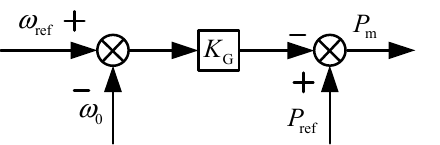
Figure 3. Control block diagram of synchronous generator governor. The active power–frequency control block diagram of the virtual synchronous gen- erator is in Figure 4. The virtual synchronous generator does not have a real rotor, and the rotor parameters are not fixed. Through the proper design of the rotational inertia J and damping coefficient D , the system can obtain a faster dynamic response and a wider ad- justment range.